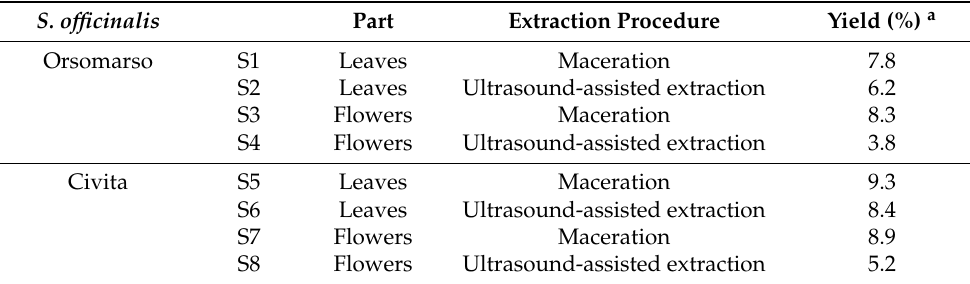
Table 2. Extraction procedures and yield (%) of S. officinalis extracts (S1-S8). S. officinalis Part Extraction Procedure Yield (%) a Orsomarso S1 Leaves Maceration 7.8 S2 Leaves Ultrasound-assisted extraction 6.2 S3 Flowers Maceration 8.3 S4 Flowers Ultrasound-assisted extraction 3.8 Civita S5 Leaves Maceration 9.3 S6 Leaves Ultrasound-assisted extraction 8.4 S7 Flowers Maceration 8.9 S8 Flowers Ultrasound-assisted extraction